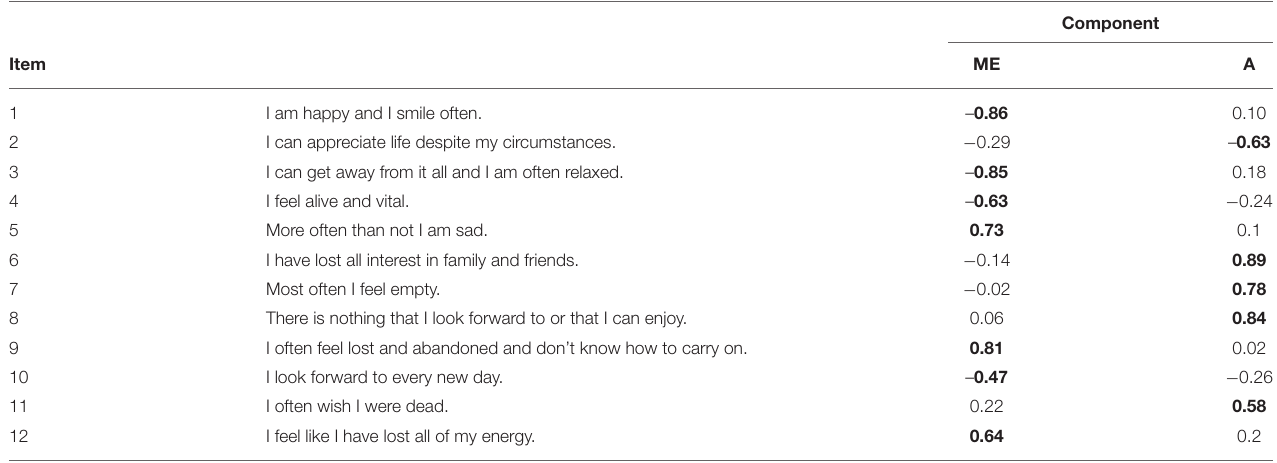
TABLE 2 | Loadings of ADI-12 items on the two components as yielded by PCA.